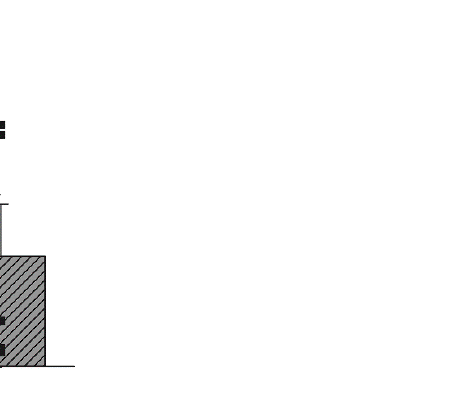
Figure 2. Impact of acute INI administration and motivation on measures of ambulatory performance in aged animals. Measures of time spent ambulating across 4 surfaces obtained in aged animals receiving INS (n = 5) or INI (n = 5). Compared to ad libitum-fed animals, a significant reduction in average time ambulating was noted in animals that were food deprived and were therefore motivated to complete the task (2-way ANOVA; F (1,16) = 7.34, p = 0.02). Additionally, a significant interaction term was also detected (F (1,16) = 6.19, p = 0.02), with INI-treated animals ambulating more quickly than INS-treated under ad libitum conditions, while this effect was reversed when animals were fasted. Data represent means ± SEM. Asterisk (*) indicates significance at p < 0.05. Figure reproduced from Lin et al., 2022 [137].